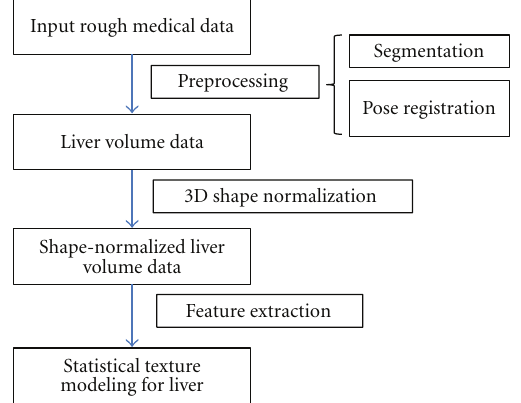
Figure 1: Basic scheme of statistical texture